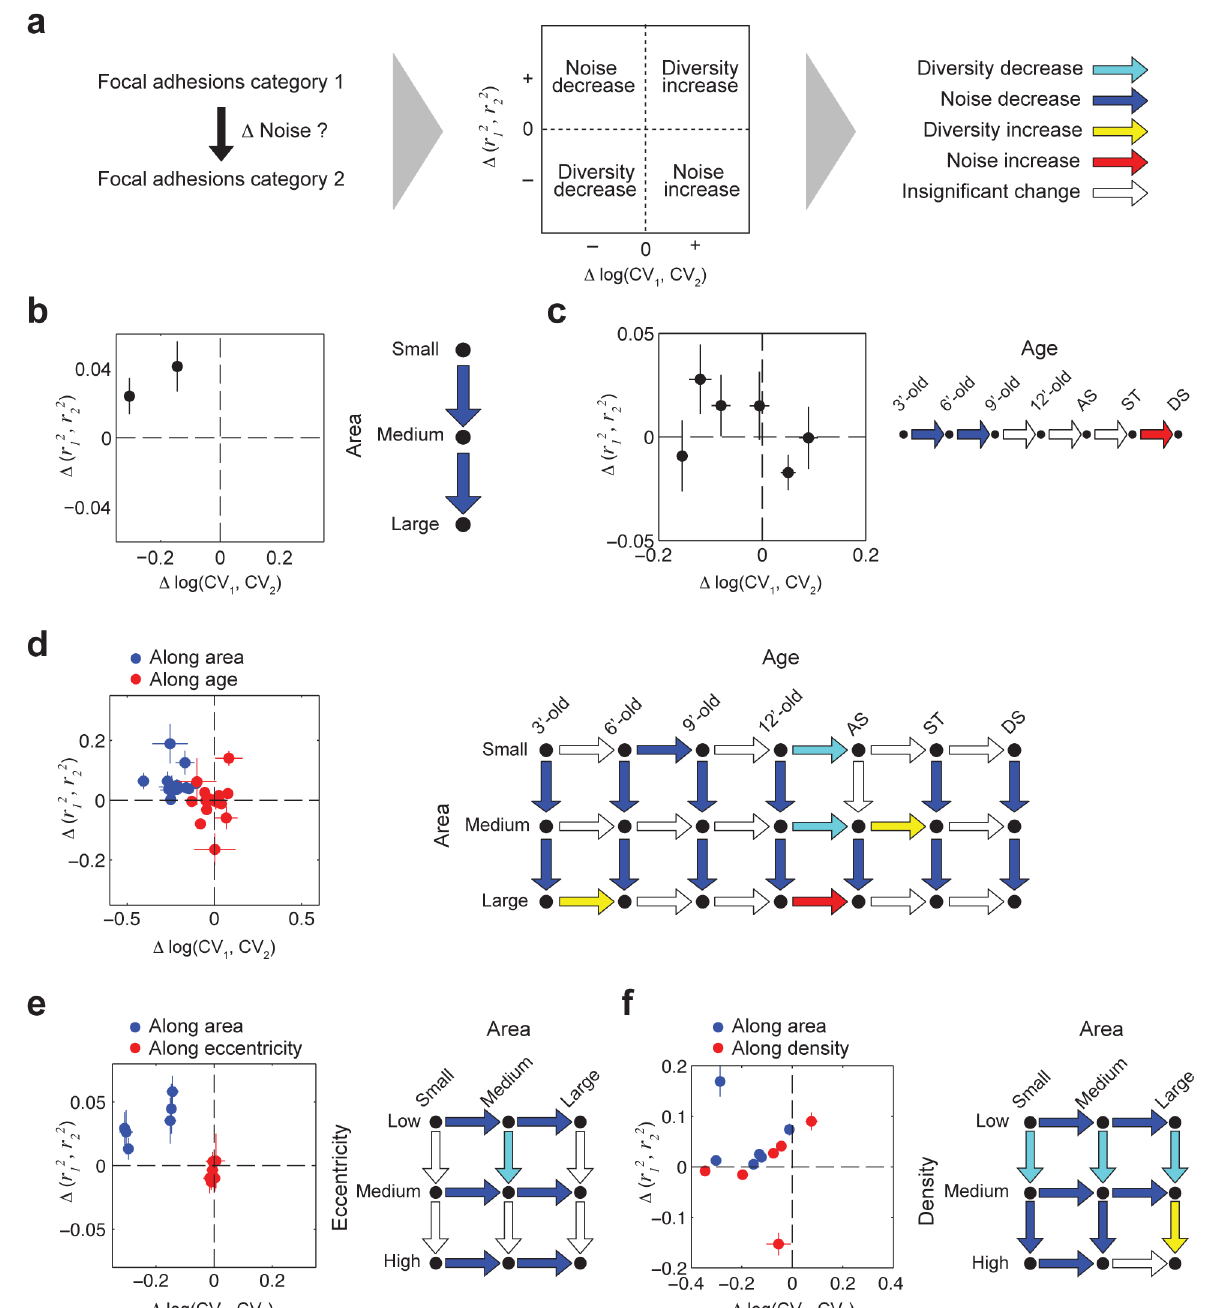
Fig 3. Noise decrease in focal adhesions is coupled to their size and internal density independently. (a) The workflow of inferring changes in noise levels between two categories of focal adhesions (e.g. small versus big focal adhesions). (b) Changes in noise levels as a function of focal adhesions area. (c) Changes in noise levels as a function of focal adhesions age. (d) Focal adhesions were sub- categorized according to both their area and age. Changes in noise levels were inferred within each age category as a function of area and vice versa. (e) Same as (d), using eccentricity instead of age. (f) Same as (d), using density instead of age. Error bars indicate standard error of the mean between datasets (see S1 Fig and S2